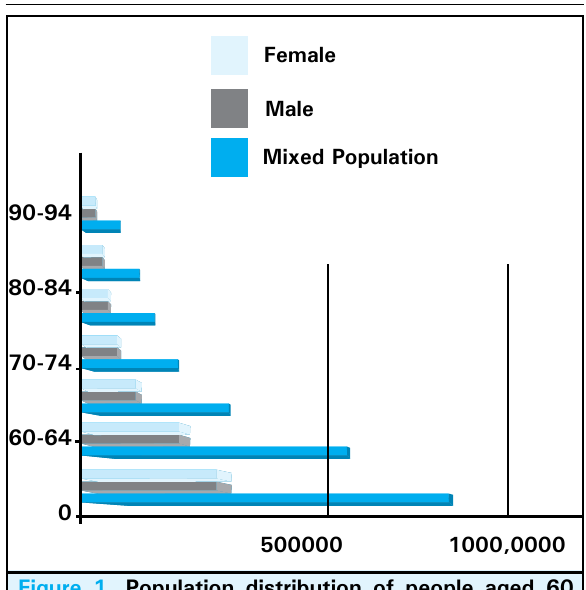
Figure 1. Population distribution of people aged 60 and above according to Gender and age band (2011 Nepal